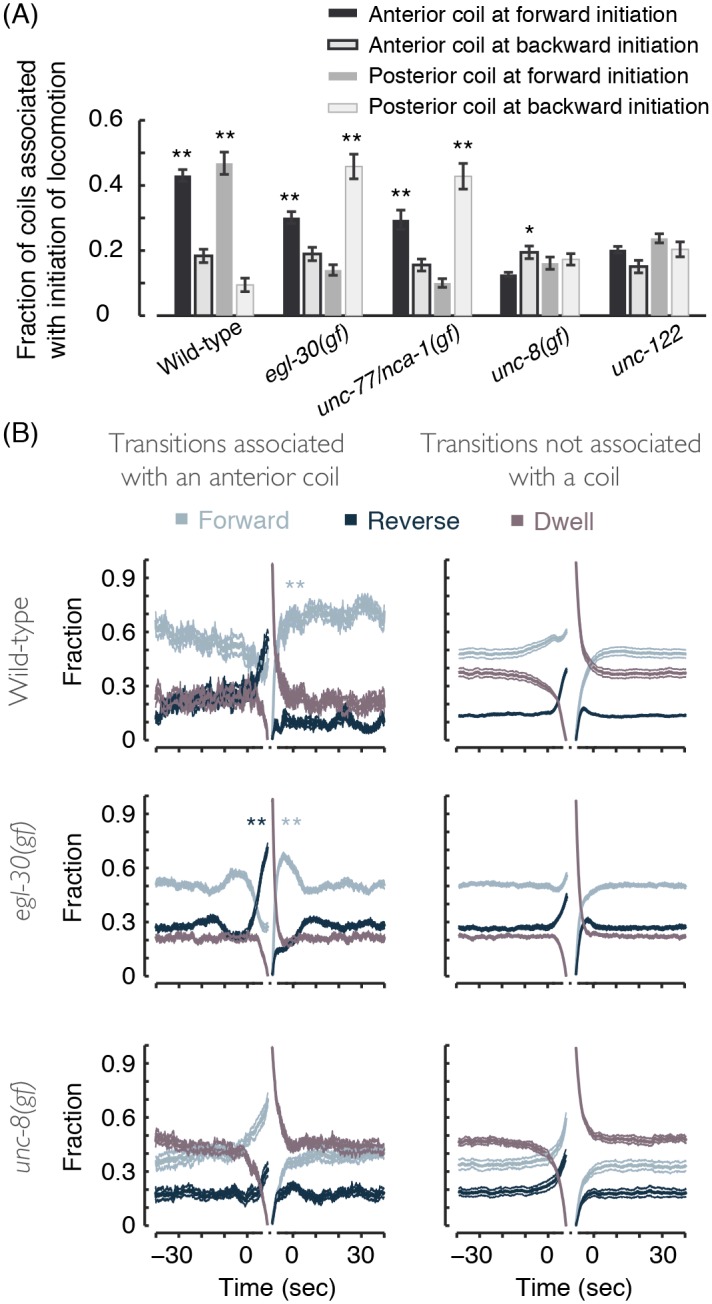
(A) The fraction of coiling events that were detected within 5 sec of the initiation of directed locomotion. Loopy movers exhibit increased probabilities of anterior or posterior coiling upon initiating forward or backward locomotion, respectively. (B) Left: the probabilities of forward locomotion, reversals, and non-directional dwelling before and after a period of dwelling, after the onset of which anterior coiling was detected. Right: the probabilities of locomotion states before and after a period of dwelling, after the onset of which coiling was not detected. The horizontal time axis depicts the time leading to and immediately following a continuous period of dwelling, i.e., the entry into and exit from a dwelling event. The gaps signify that locomotion during the (variable) time of the coiling events themselves is not plotted. In all panels, 9–12 L4 larvae of each genotype were assayed for 2–4 hours. Error bars and thin lines depict animal-to-animal variation (mean ± s.e.m).